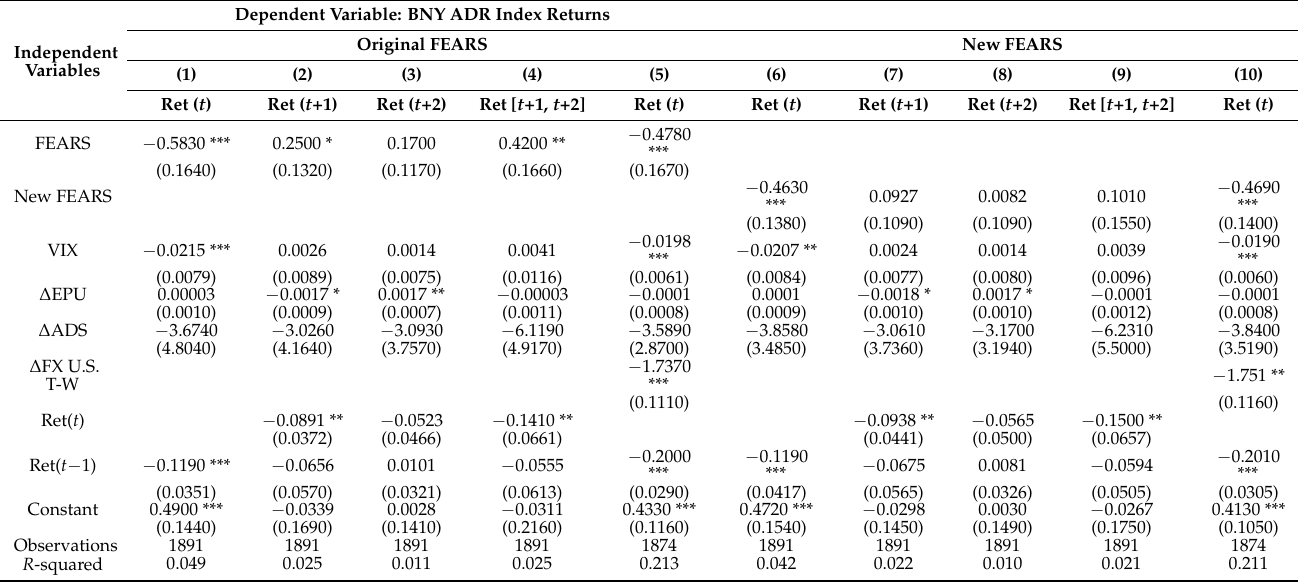
Table 6. FEARS and the BNY ADR Index.